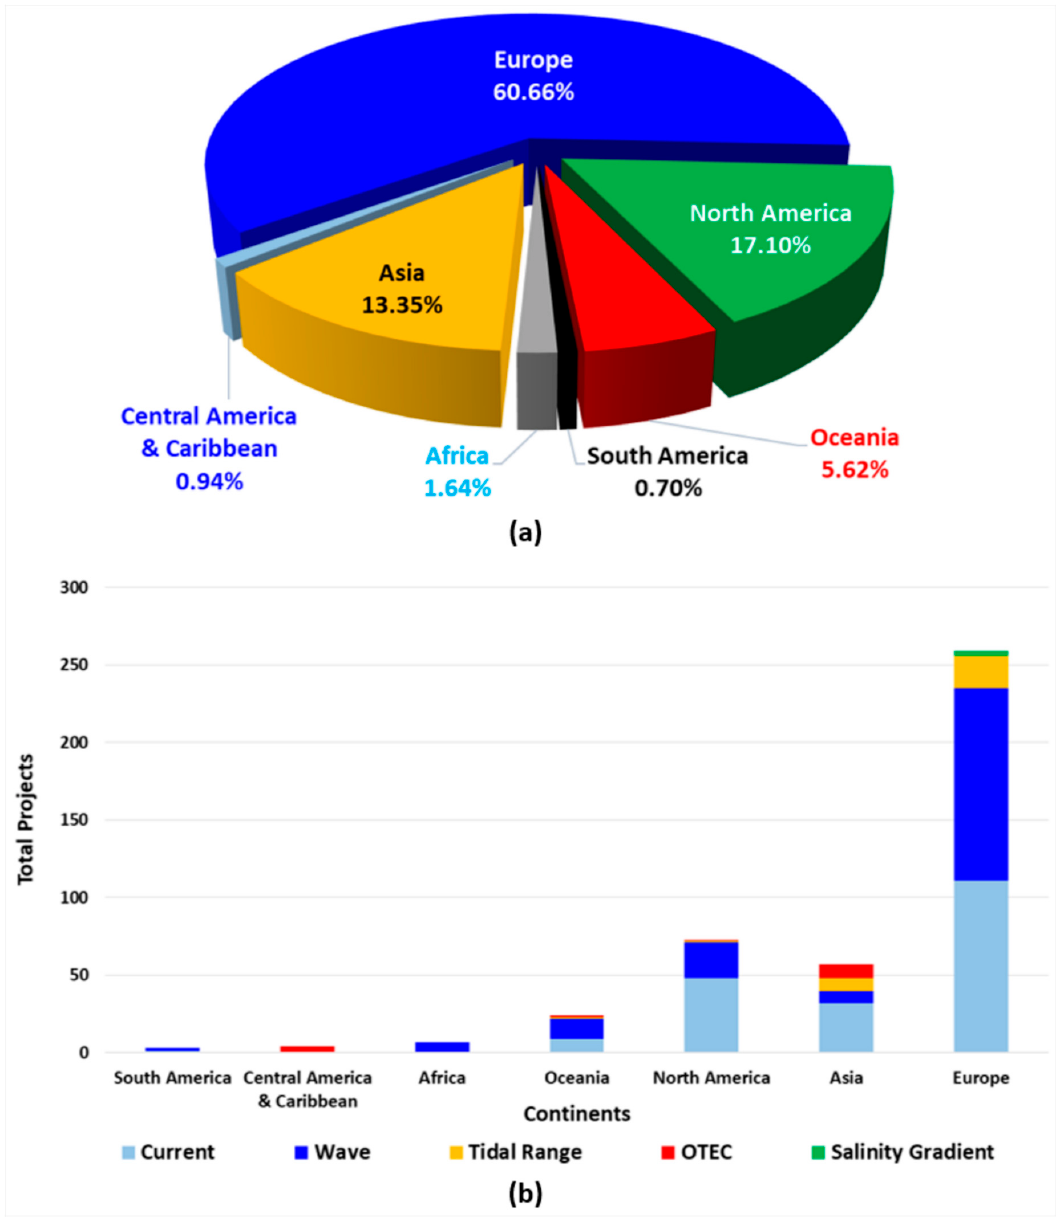
Figure 10. Distribution of the ocean renewable energy projects by (a) continent and (b) source for each